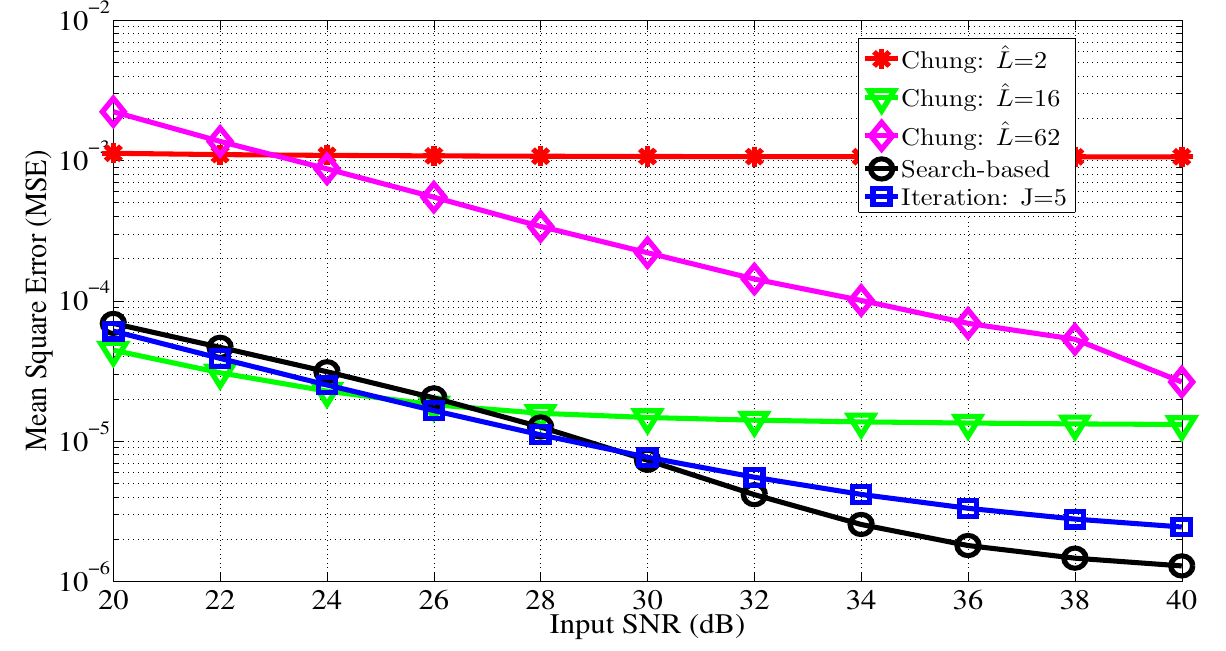
Figure 4. MSE performance of the proposed and Chung’s CFO estimators for different SNRs. N = 256, K = 64, (cid:15) = 0.3, τ = 4 and J = 5. d